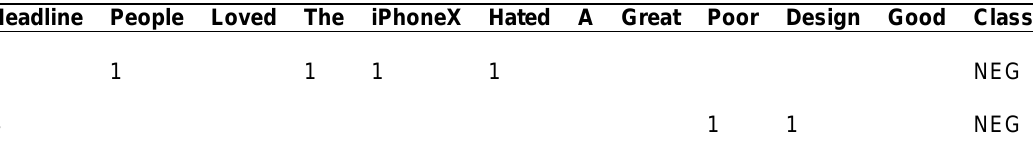
Table 4. Feature matrix of only negative